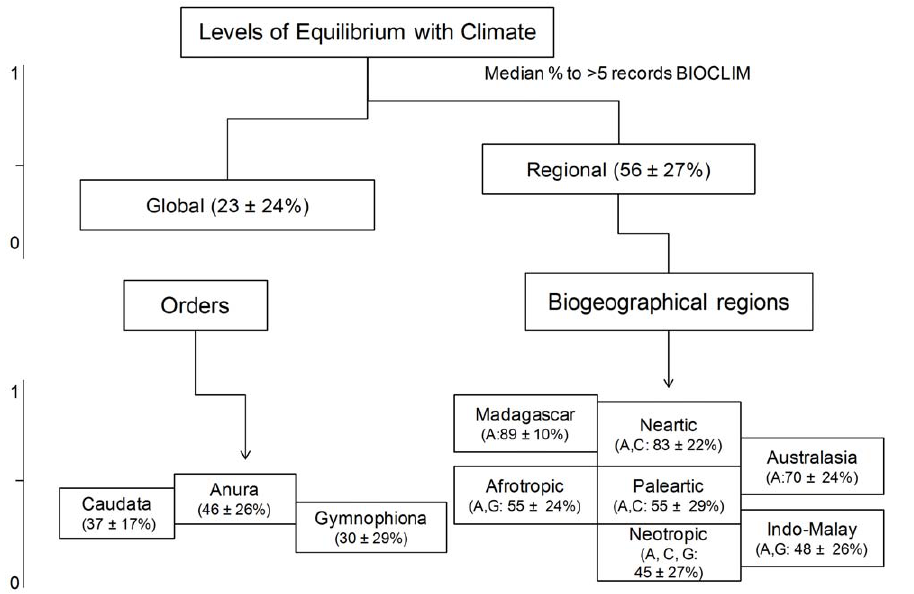
Figure 2. Diagram of climate equilibrium levels at global and regional scales, biogeographical regions and orders. We only show Neotropical orders in the diagram because that show all orders: Caudata (C=salamanders), Anura (A=frogs and toads) and Gymnophiona (G=cecilians), however all regions were analyzed by region (see text). doi:10.1371/journal.pone.0034420.g002 PLoS ONE |